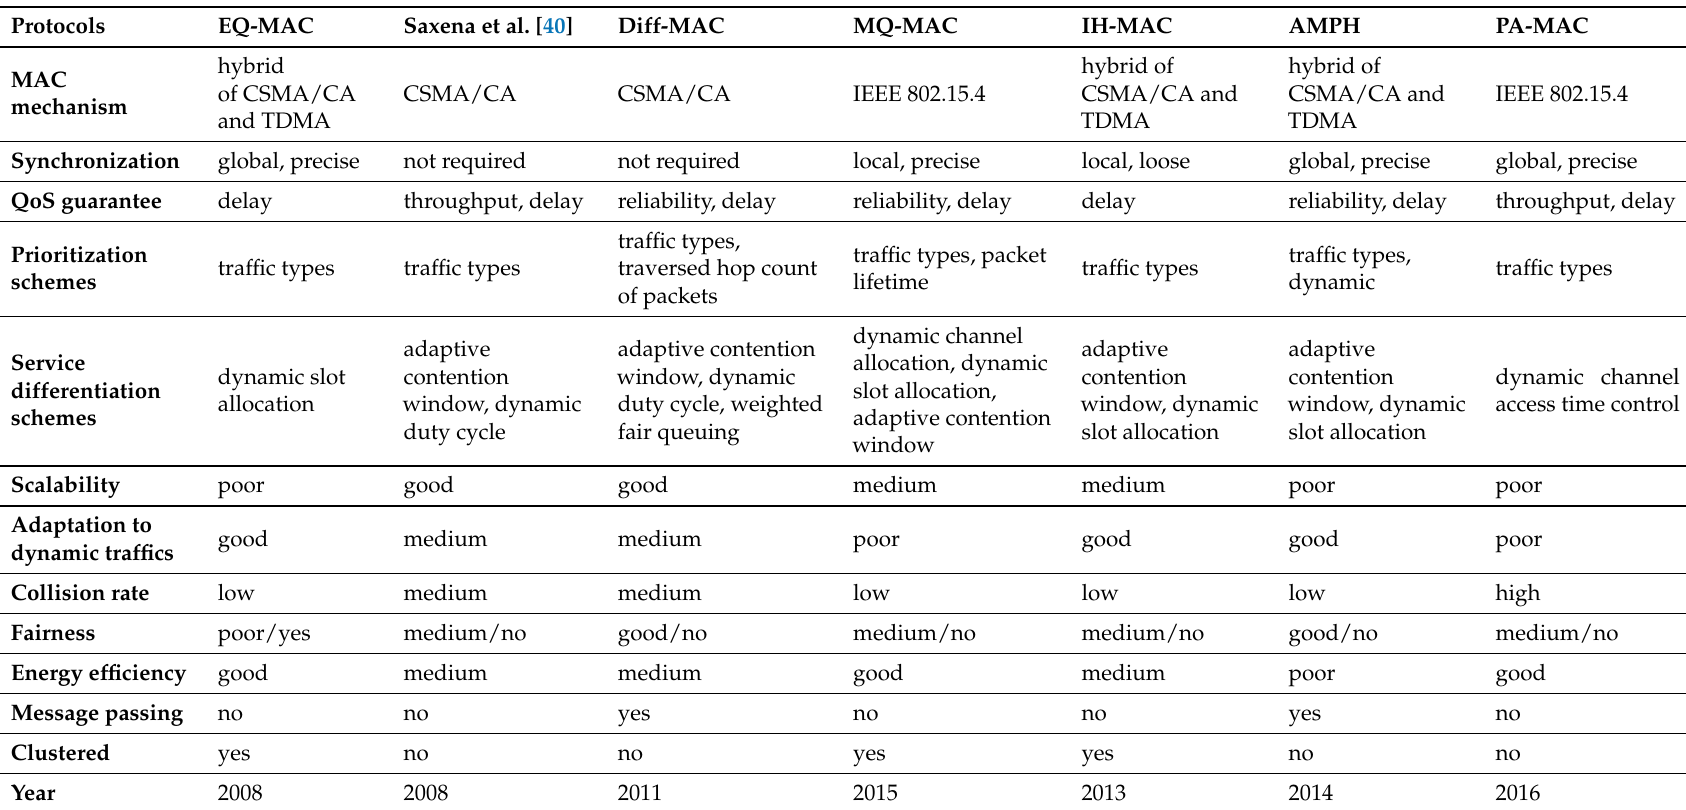
Table 2. A comparison of surveyed MAC